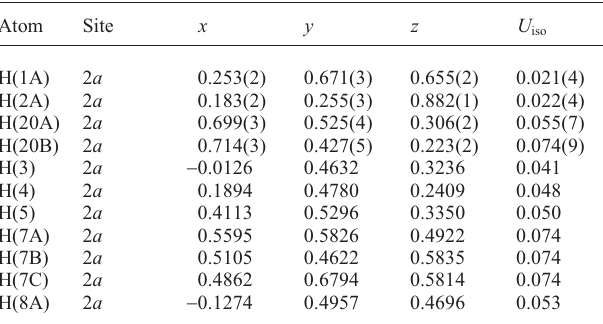
Table 2. Atomic coordinates and displacement parameters (in Å 2 )